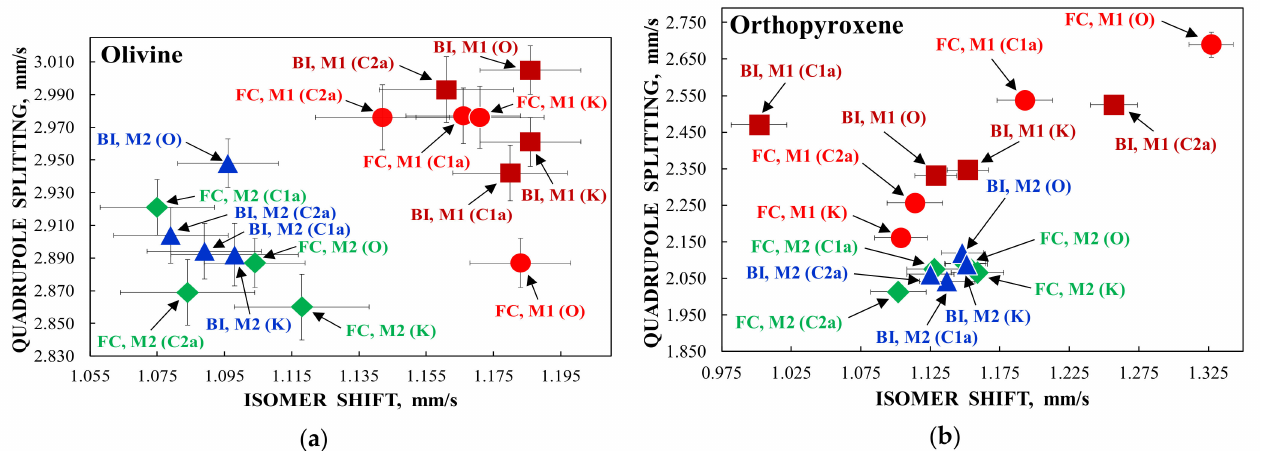
Figure 53. Comparison of the 57 Fe hyperfine parameters for the M1 and M2 sites in olivine ( a ) and orthopyroxene ( b ) in the bulk interior ( BI ) and the fusion crust ( FC ) in ordinary chondrites Chelyabinsk LL5, fragments No 1a and No 2a ( C1a and C2a ), Ozerki L6 ( O ) and Kemer L4 ( K ). —bulk interior, M1 sites, —bulk interior, M2 sites, —fusion crust, M1 sites, —fusion crust, M2 sites. Adapted from Reference [100] with incorporation of new data from